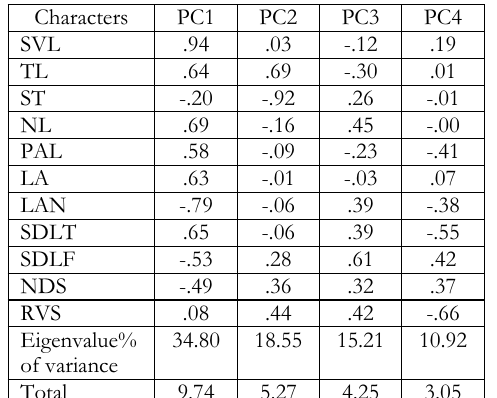
T ABLE 4. -Factor loadings for the first four principal components derived from all specimens of T. aurata transcaucasica and T. septemtaeniata . Eleven of thirty-one characters are statistically significant and meet selection criteria for the PCA.